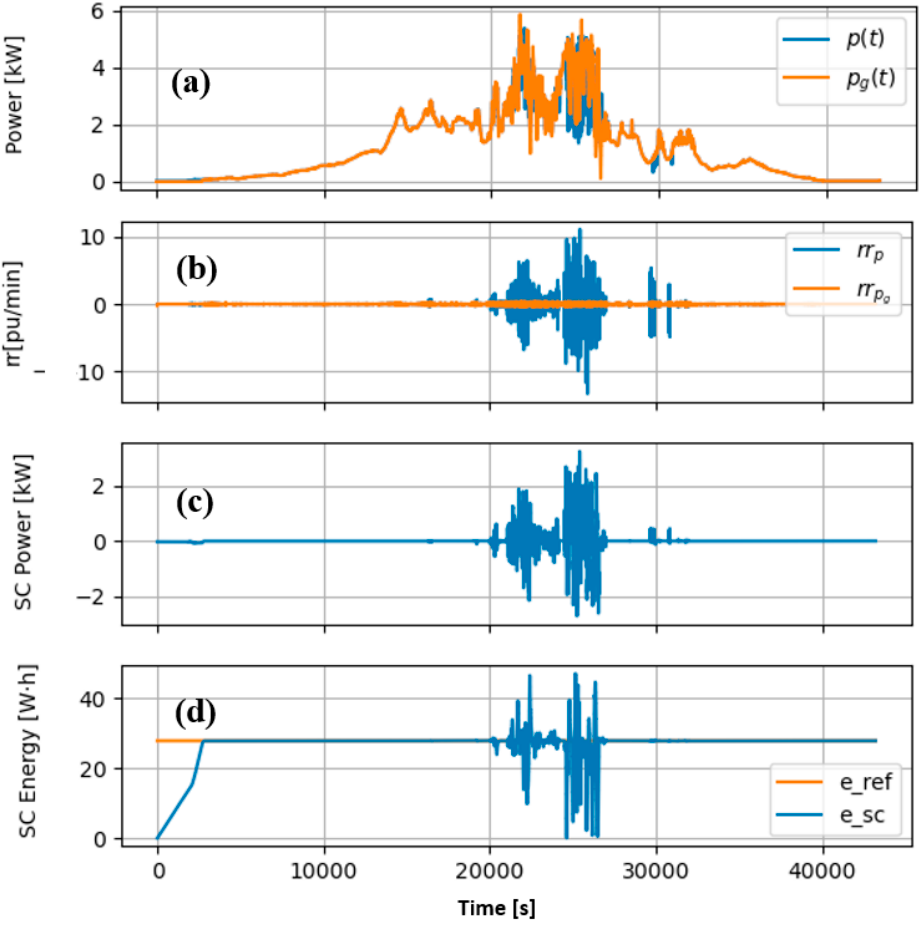
Figure A1. Power Smoothing Performed by the Super-Capacitor: ( a ) blue curve: measurements of the PV power of a real 6 kW p PV system in Germany with resolution of 1 s; orange curve: the active power finally injected in the grid after the performance of the power smoothing algorithm; ( b ) blue curve: the ramp-rate of the real active power in pu / min; orange curve: the ramp-rate of the smoothed power in pu / min; ( c ) the power absorbed / released by the supercapacitor (SC); ( d ) the SC energy along with its reference value.